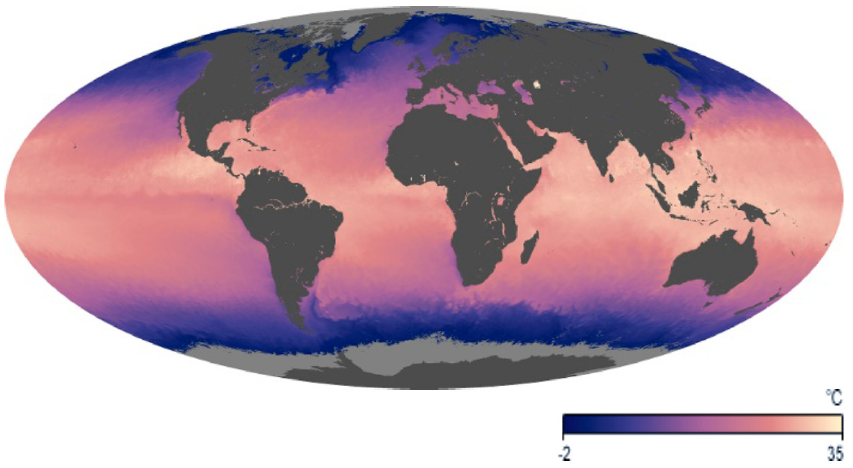
Figure 2. Global water surface temperatures as seen in a satellite image from May 2022. Courtesy of https://earthobservatory.nasa.gov/global-maps/MY1DMM_CHLORA/MYD28M (accessed on 1 February 2023).